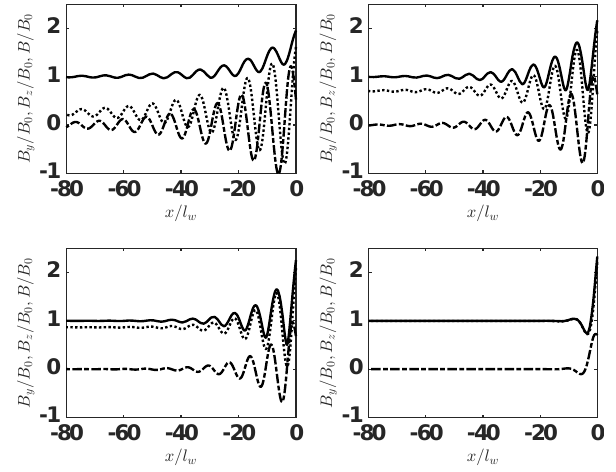
Figure 5. The total magnetic field (solid line) and the two perpen- dicular components, B z /B 0 (dotted) and B y /B 0 (dash-dotted). Top left: θ = 15 ◦ ; M = 2 . 04. Top right: θ = 45 ◦ ; M = 2 . 24. Bottom left: θ = 60 ◦ ; M = 2 . 31. Bottom right: θ = 85 ◦ ; M = 2 . 38. Other parameters: β = 0 . 5; M F =